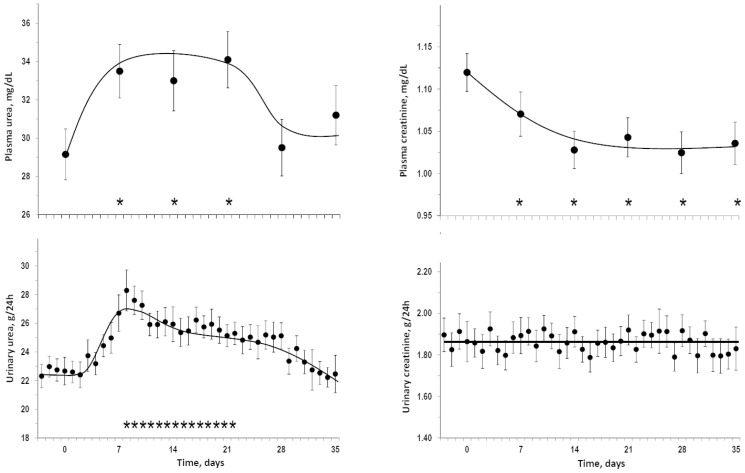
Urea and creatinine during bedrest.Mean±SEM pre-bedrest and during bedrest of plasma and urinary levels of urea and creatinine. Stars above the x-axis lines indicate time-points which were statistically different versus day0 (P<0.05).